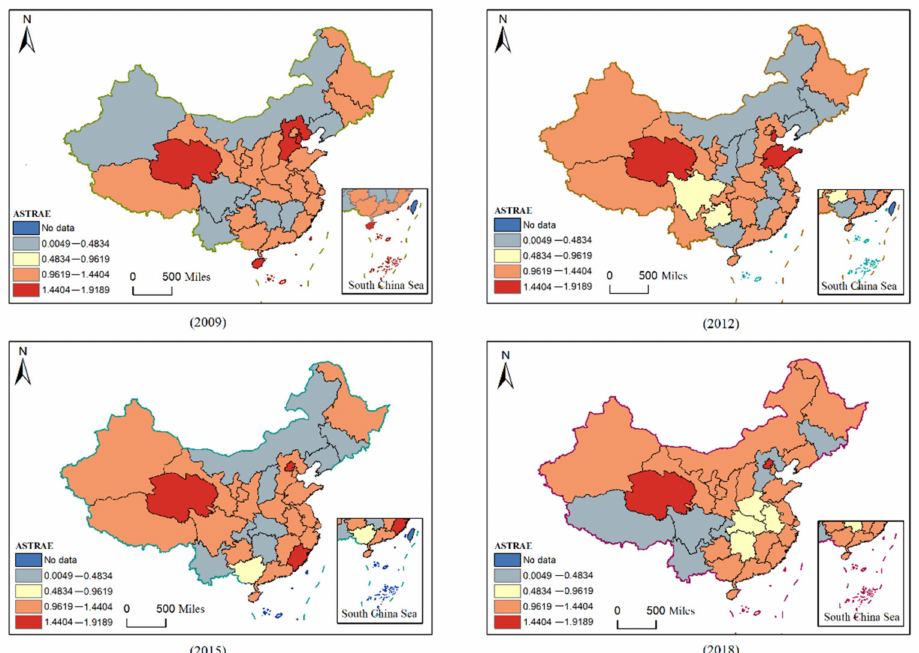
Figure 1. Temporal and spatial evolution analysis of